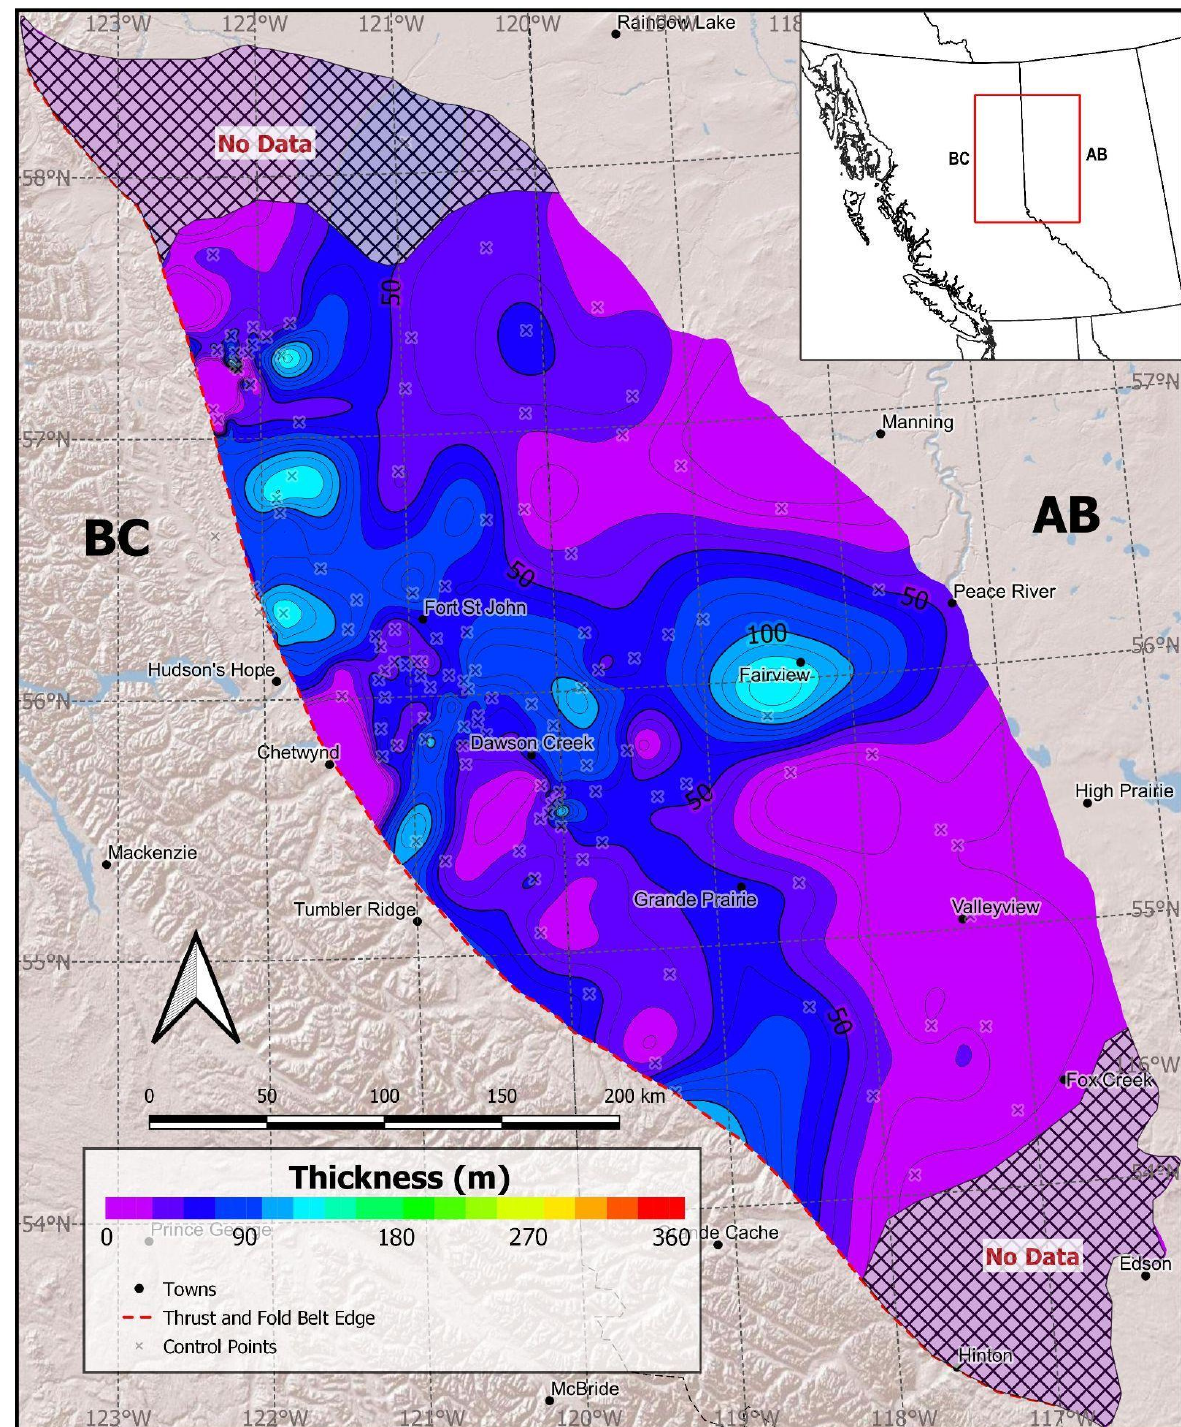
Figure 6. Thickness distribution of the Lower Montney Formation in British Columbia and Alberta. The Lower Montney Formation is inconsistent in its thickness distribution with localised thicknesses along the deformation front and near Fairview,